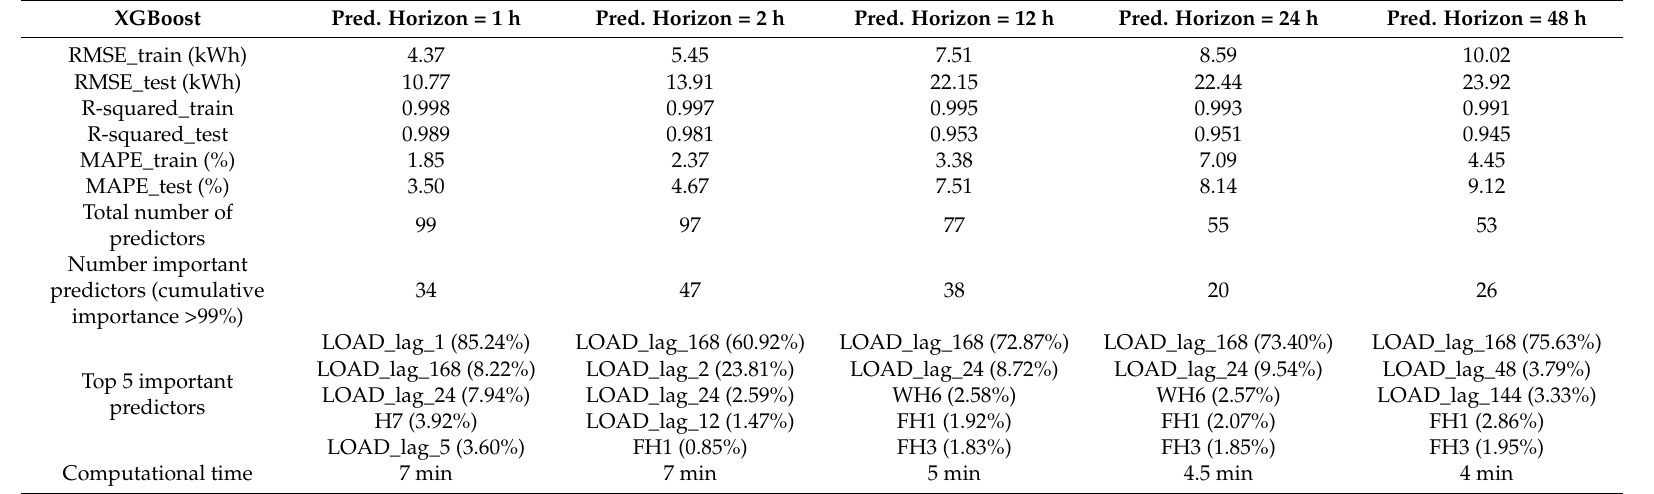
Table 8. Results for XGBoost method and different prediction